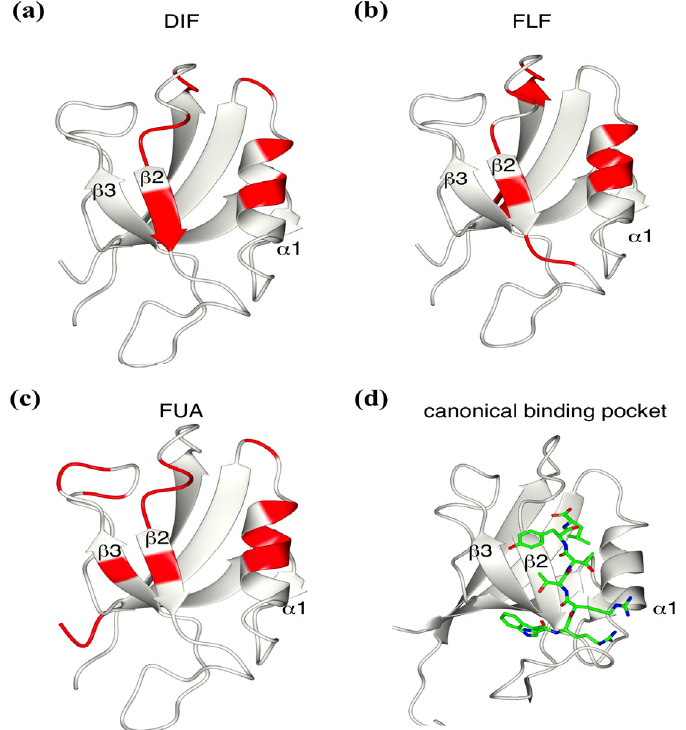
Figure 3. Identification of the interface between the mZO-1 PDZ1 domain and a compound. Mapping of residue signal changes upon mixing with DIF ( a ), FLF ( b ), and FUA ( c ) onto the ribbon model of the mouse ZO-1 PDZ1 domain (PDB:2RRM). ( d ) The ribbon model represents the canonical binding pocket between the PDZ domain and peptide